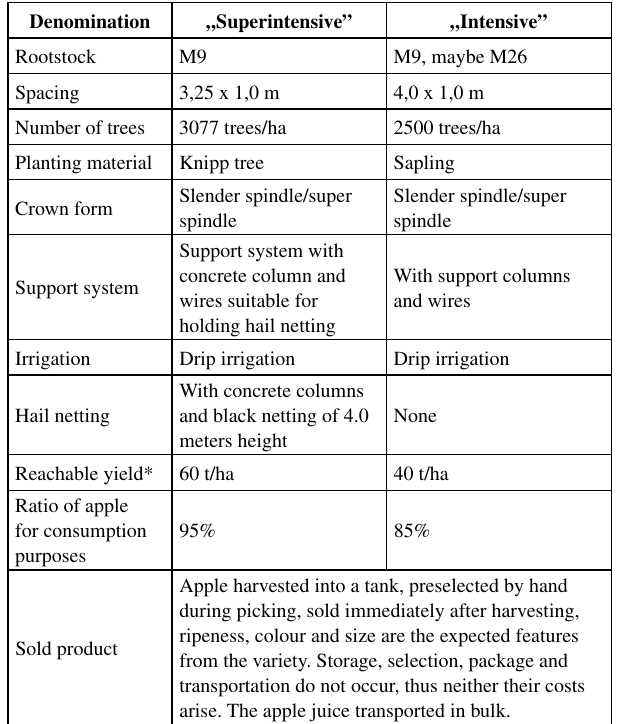
Table 1: Parameters of the Characterized Superintensive and Intensive Apple Orchards